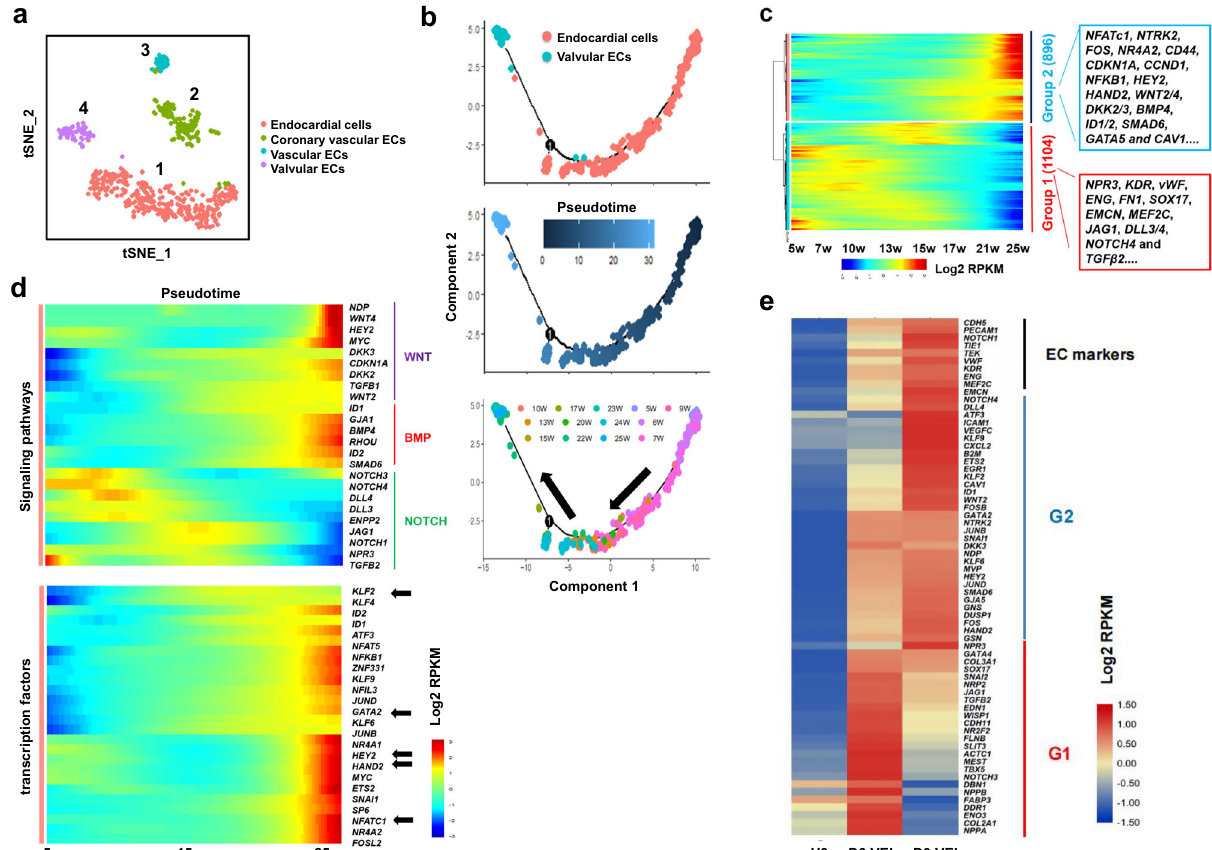
Fig. 3 Analysis of the primary VECs at single cell level showing that hPSC VEL differentiation recapitulates embryonic VEC development. a The t-distributed stochastic neighbor embedding (t-SNE) showing unbiased clustering results of endothelial cells 36 . Four different ECs were identi fi ed: 1 (endocardial cells), 2 (coronary vascular ECs), 3 (vascular ECs) and 4 (valvular ECs). b Pseudotime trajectory showing the distribution of cardiac endothelial cells. Top: distribution of endocardial cells and valvular ECs along pseudotime trajectory; middle: pseudotiming of endocardial and valvular ECs; and bottom: distribution of cells with exact developmental time points. Black arrows show the direction of pseudotime across trajectories. c Heat map illustrating the dynamic gene expression patterns of group 1 (G1) and 2 (G2) genes. Note: G1 genes are primarily expressed at early stages; while G2 are highly expressed at later stages. d Heat map illustrating the dynamic gene expression patterns of the indicated signaling pathway genes (top panel) and transcription regulatory genes (bottom panel) identi fi ed in G2. Black arrows pointing to TFs with well-known function in VEC induction and/or formation. e Heat map showing expression of a panel of G1 and G2 genes for day 6 and day 9 hPSC-derived VEC-like